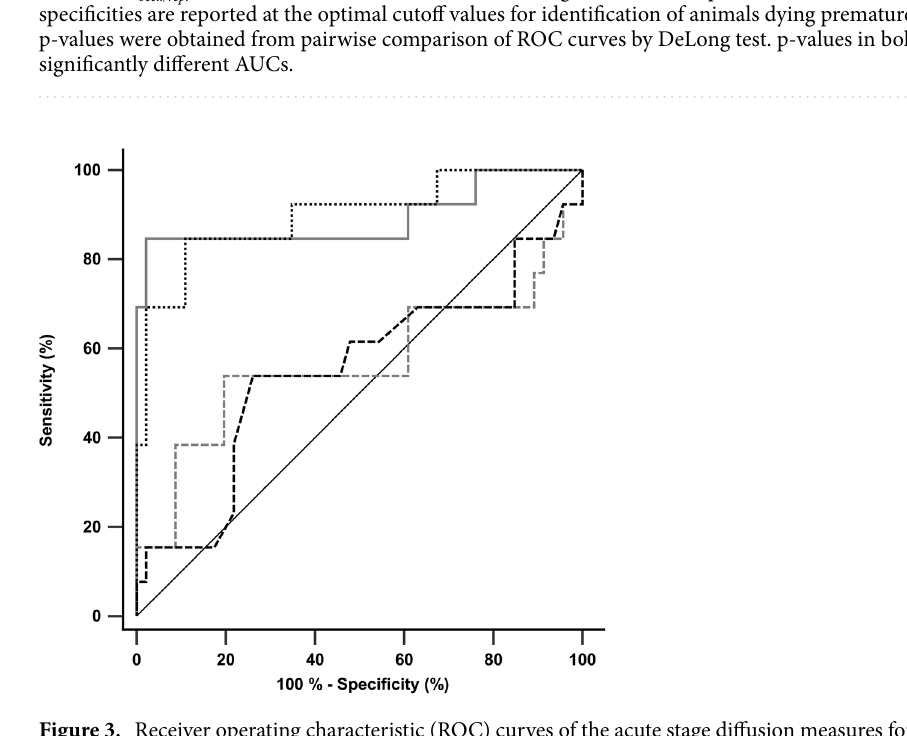
(Supplementary Table 1). Kaplan–Meier curves illustrating the cumulative survival functions for animals grouped according to optimal ROC-derived cutoff points of acute stage diffusion measures are shown in Supplementary Fig. 1. Each animal in the survival group (n = 46) showed decreased ADC lesion volume at reperfusion compared to that during occlusion, thus Wilcoxon signed-rank test indicated a statistically significant difference between the two timepoints (2-sided exact p < 10 –6 , example shown in Fig. 2A). On the other hand, non-survival group showed more mixed pattern (4/9 rats with increased/decreased lesion volume at reperfusion) resulting in only a nonsignificant trend towards decreased ADC lesion volume at reperfusion (2-sided exact p = 0.080, example shown in Fig. 2A). Similarly, each survival animal showed increased mean ADC of the initial lesion site at reper- fusion compared to that during occlusion (2-sided exact p < 10 –6 ). The non-survival group also showed increased ADC at reperfusion, but with a less statistically significant p-value (2-sided exact p = 0.017). Almost each survival animal (i.e. 44 from 46) showed increased final lesion volume compared to that at reperfusion and most of the animals (i.e. 40 from 46) showed decreased final lesion volume compared to that during occlusion, resulting statistically significant differences in both cases (2-sided exact p < 10 –6 ).